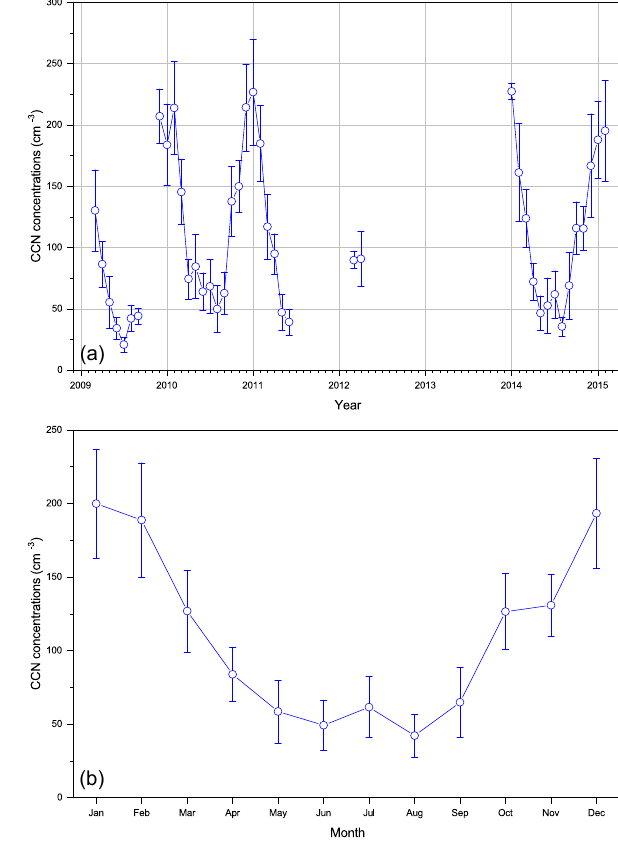
Figure 7. (a) Monthly mean CCN concentrations at the SS of 0.4% with a standard deviation from March 2009 to February 2015. (b) Seasonal variation in mean CCN concentrations at the SS of 0.4% with a standard deviation.